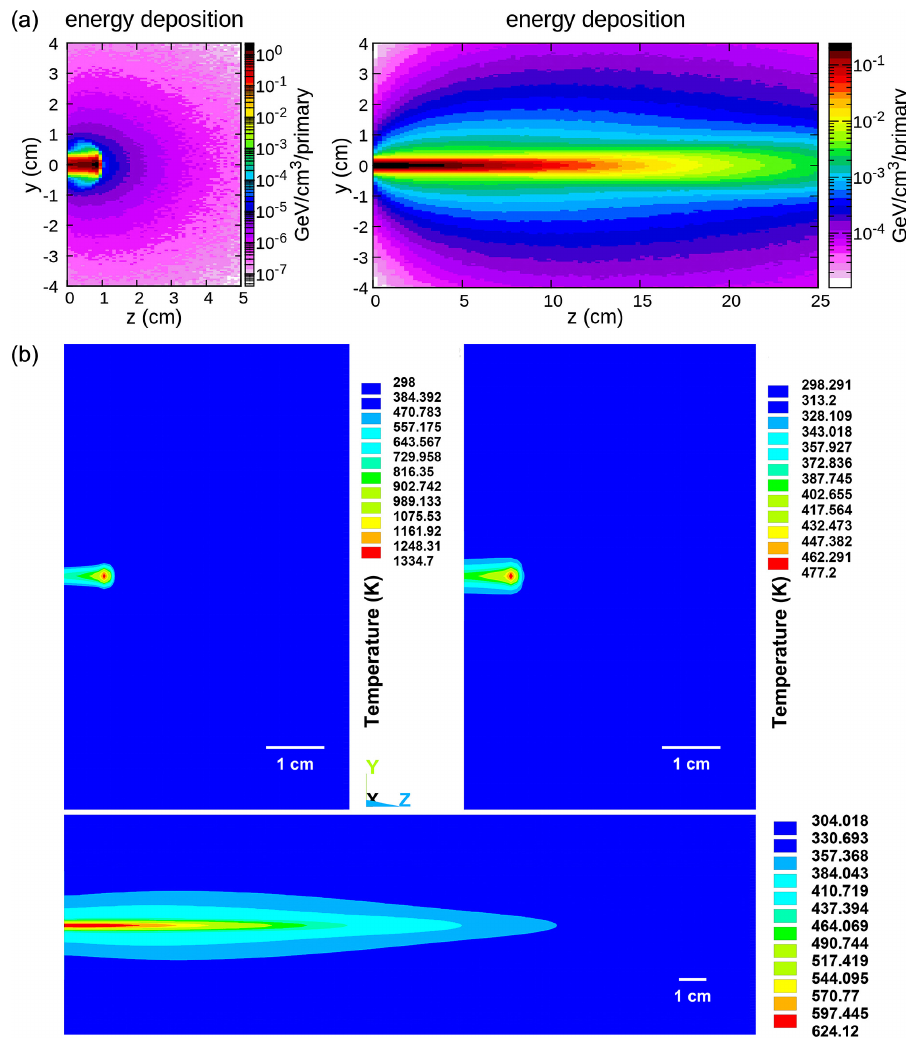
FIG. 22. (a) Energy deposition maps for proton impacting at 80 MeV (left) and 1.6 GeV (right). (b) The temperature distribution in copper for proton impacting at 80 MeV just after 1.7 bunches delivered (top left) and 100 bunches delivered at 10% loss rate (top right), and the bottom plot is the case of 1.6 GeV just after 80 bunches